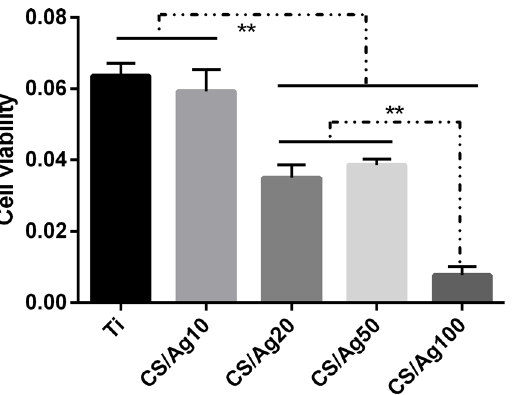
Fig 9. Cell viability of MC3T3 on the specimens after culturing for 3 days determined by CCK-8 assay. The data are expressed as means ± standard deviations (n = 3). One-way ANOVA followed by SNK post hoc test is utilized to determine the level of significance. * p < 0.05 and ** p <